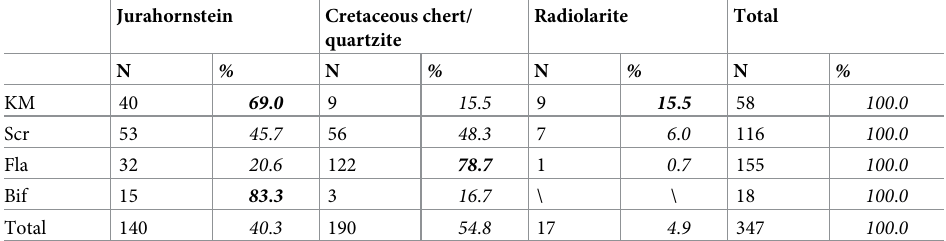
Table 5. Raw material for techno-typological category of